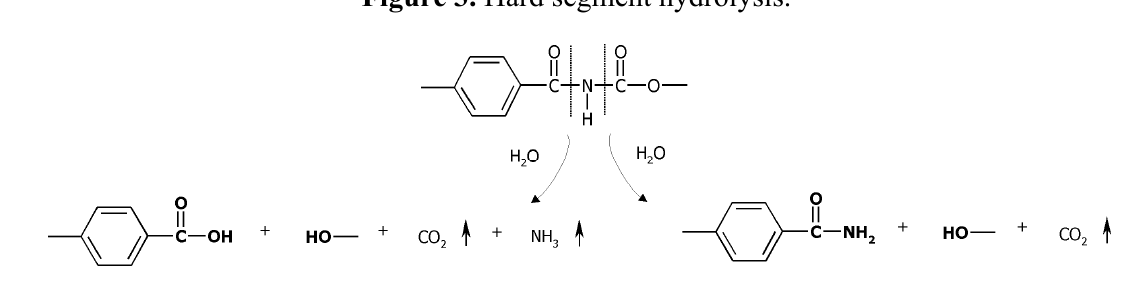
Figure 3. Hard segment